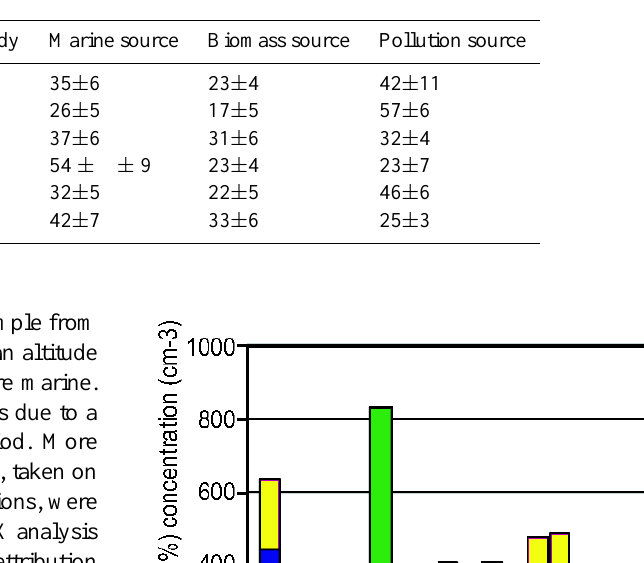
Table 3. Study mean values of the source contributions to both CCN activity and aerosol light scattering for each of the CARMA studies, together with their associated uncertainties. Values are in percentages of the total contribution.